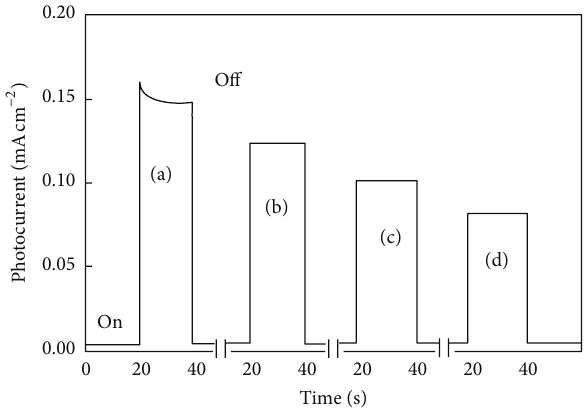
Figure 6: Photocurrent-voltage ( J-V ) curves for the DSSCs sen- sitized by four kinds of natural dyes: (a) teak, (b) tamarind, (c) eucalyptus, and (d) bottle brush under visible light illumination of intensity 256mW/cm 2 (electrolyte composition: 0.2 MLiI, 0.02MI 2 in propylene carbonate). Curve (e) is the same for bare TiO 2 electrode.